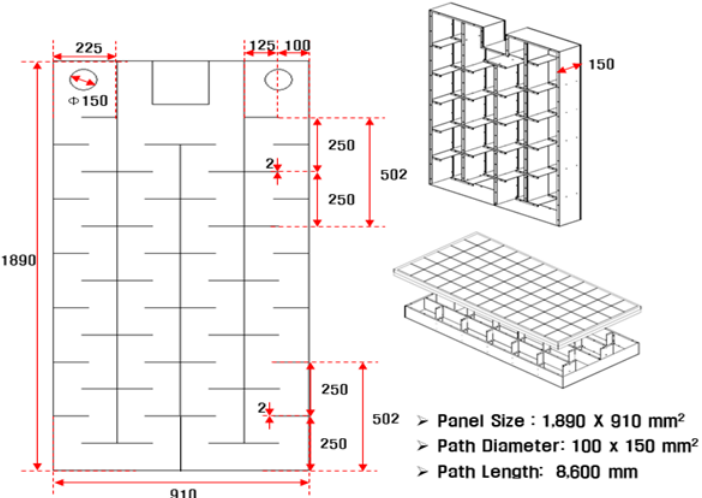
Figure 2. PVT air baffle baseline design information. Table 2. ISO 9806 standard sensor uncertainty.